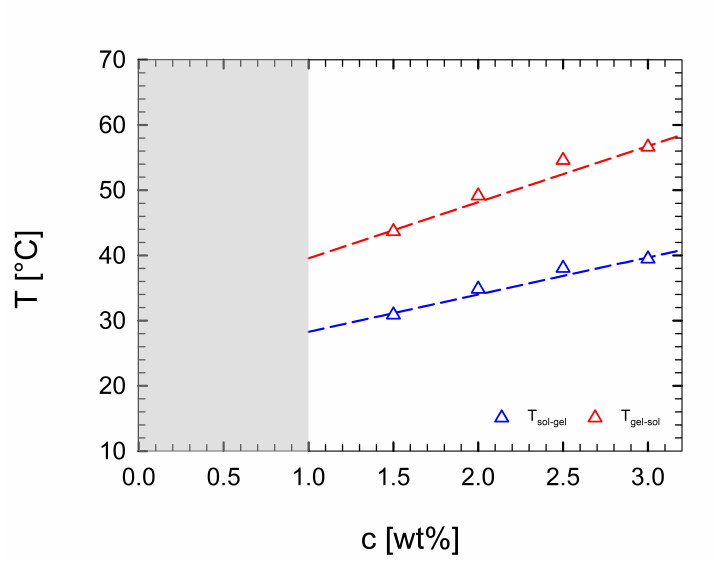
Figure 5. T sol - gel (blue symbols) and T sol - gel (red symbols) as a function of κ -c percentage concentration.